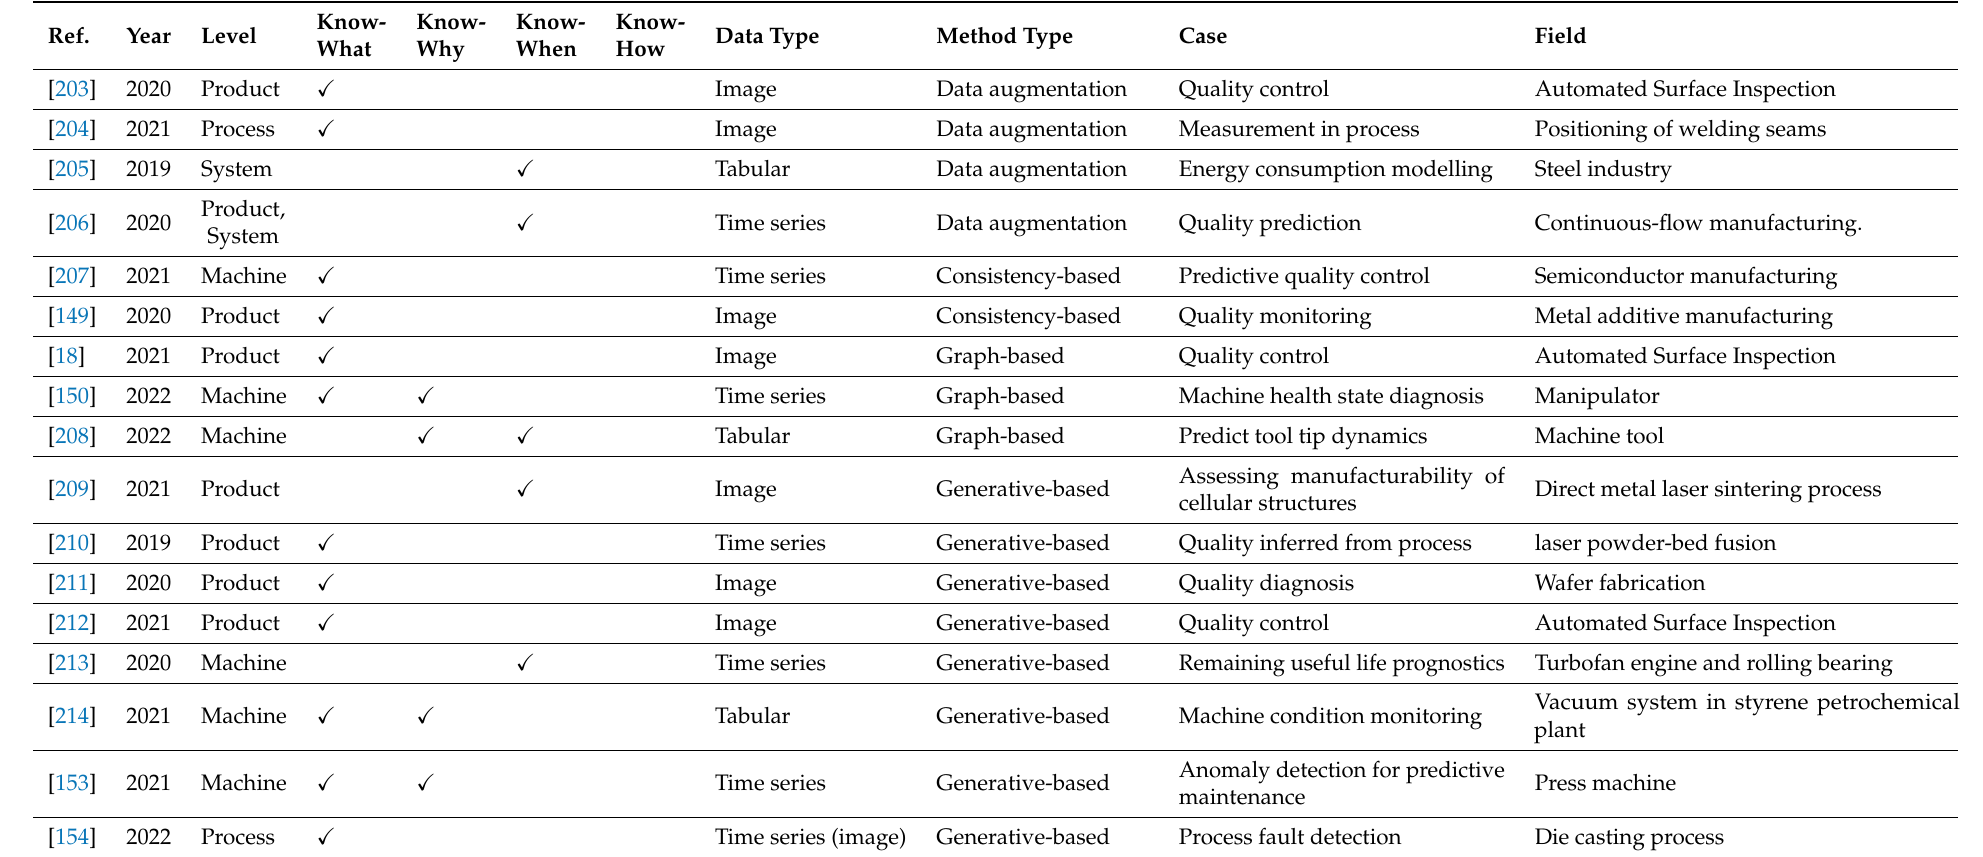
Table A3. Categories of semi-supervised learning